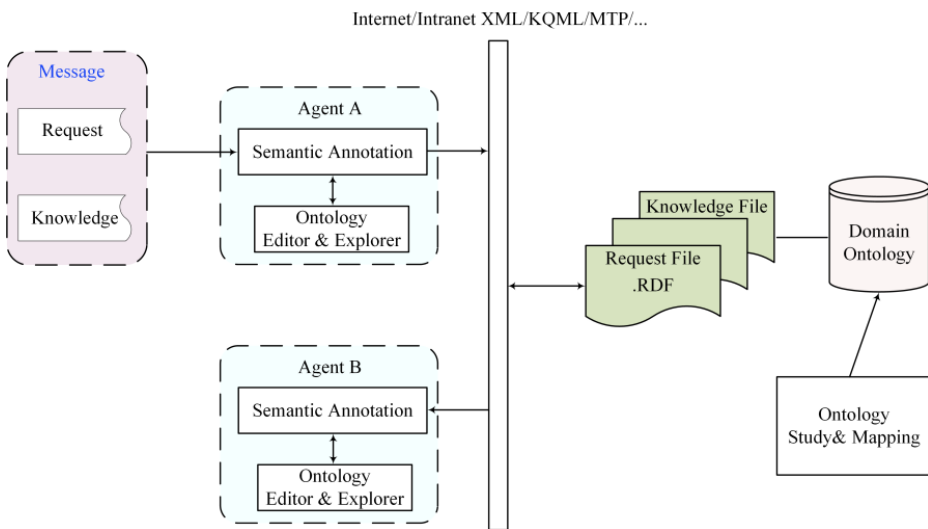
Figure 7. Agent communication mechanism within a multi-agent system (MAS).